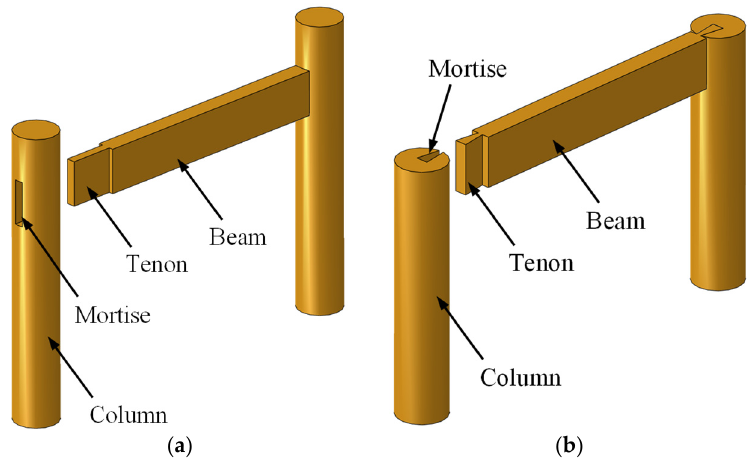
Figure 2. Timber frame with mortise-tenon joints: ( a ) Straight joint; ( b ) dovetail joint.